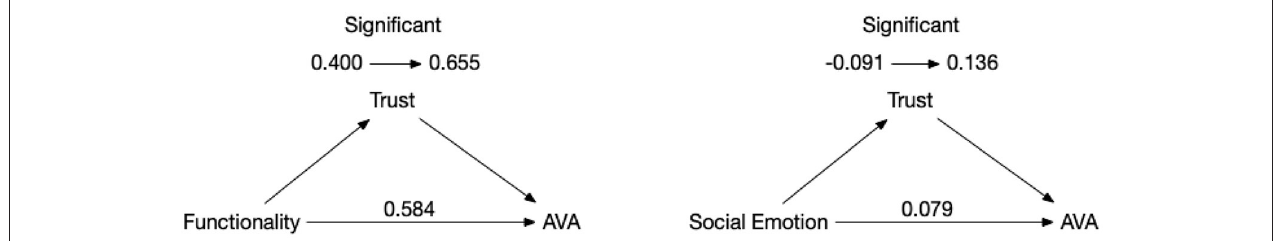
FIGURE 2 | Intermediary role test